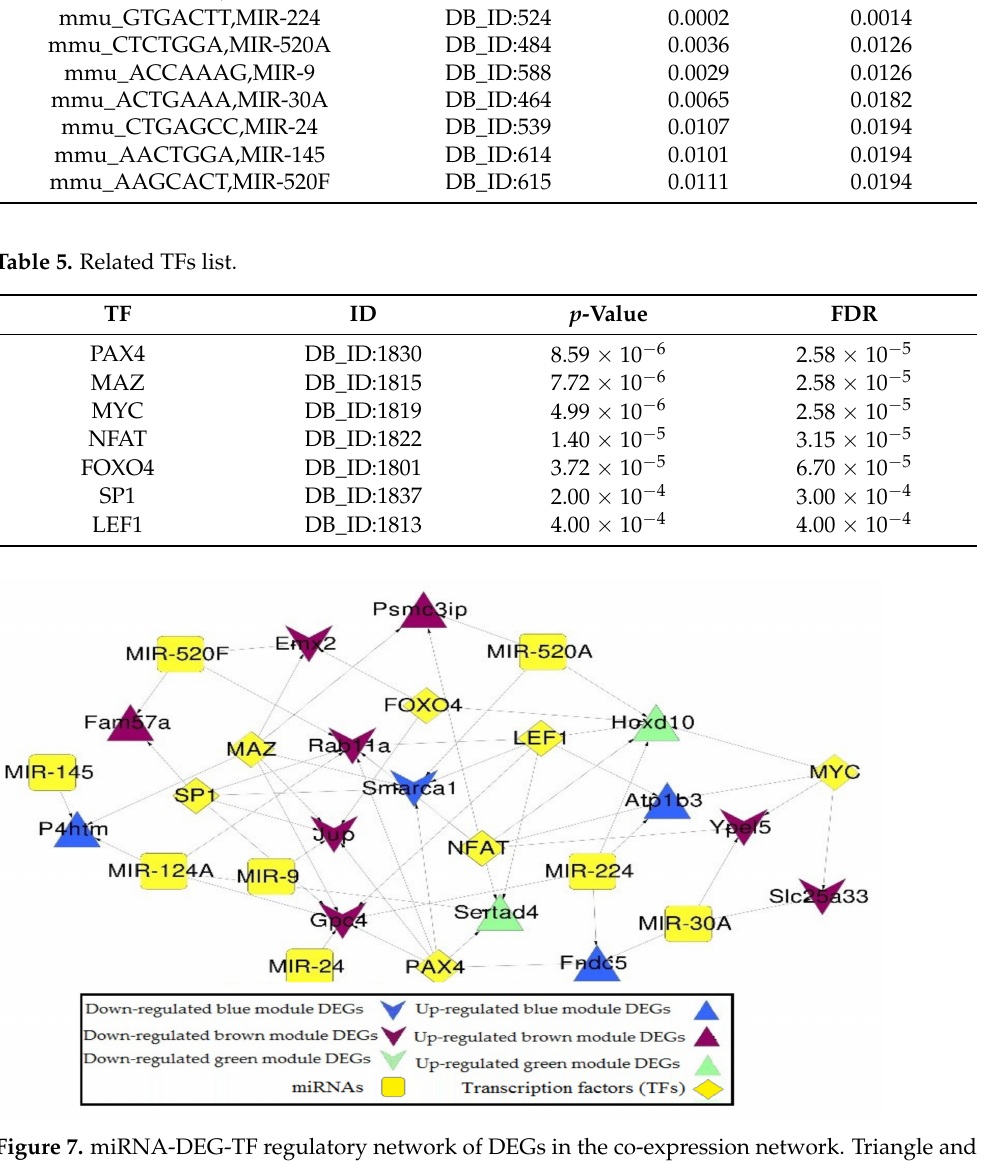
Figure 7. miRNA-DEG-TF regulatory network of DEGs in the co-expression network. Triangle and inverted triangles refer to up and down-regulated DEGs; blue, green, and brown nodes mean genes from the corresponding colored module. Yellow square and diamond mean miRNAs and